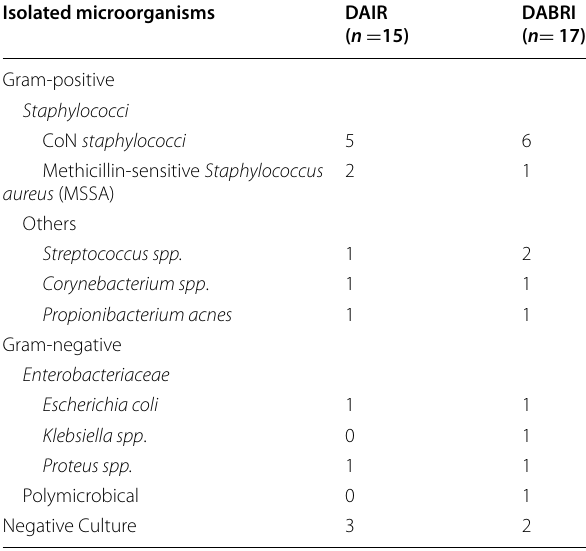
CoN Coagulase-Negative, spp. species plural